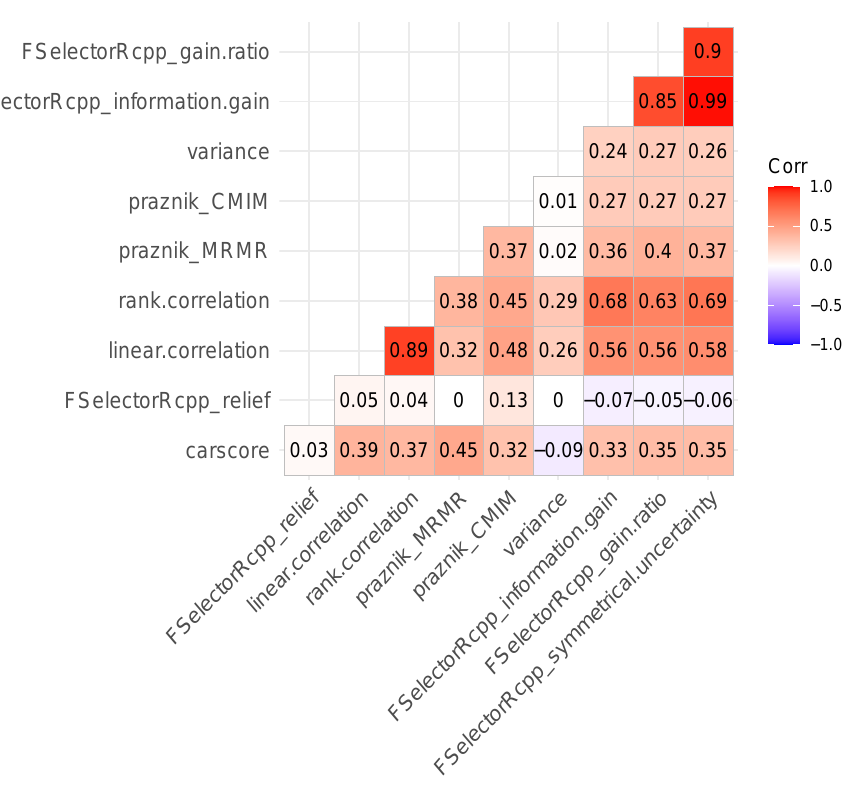
Figure A1. Spearman correlations of NRI feature rankings obtained with different filters. Filter names refer to the nomenclature used by the mlr R package. Underscores in names divide the terminology into their upstream R package and the actual filter